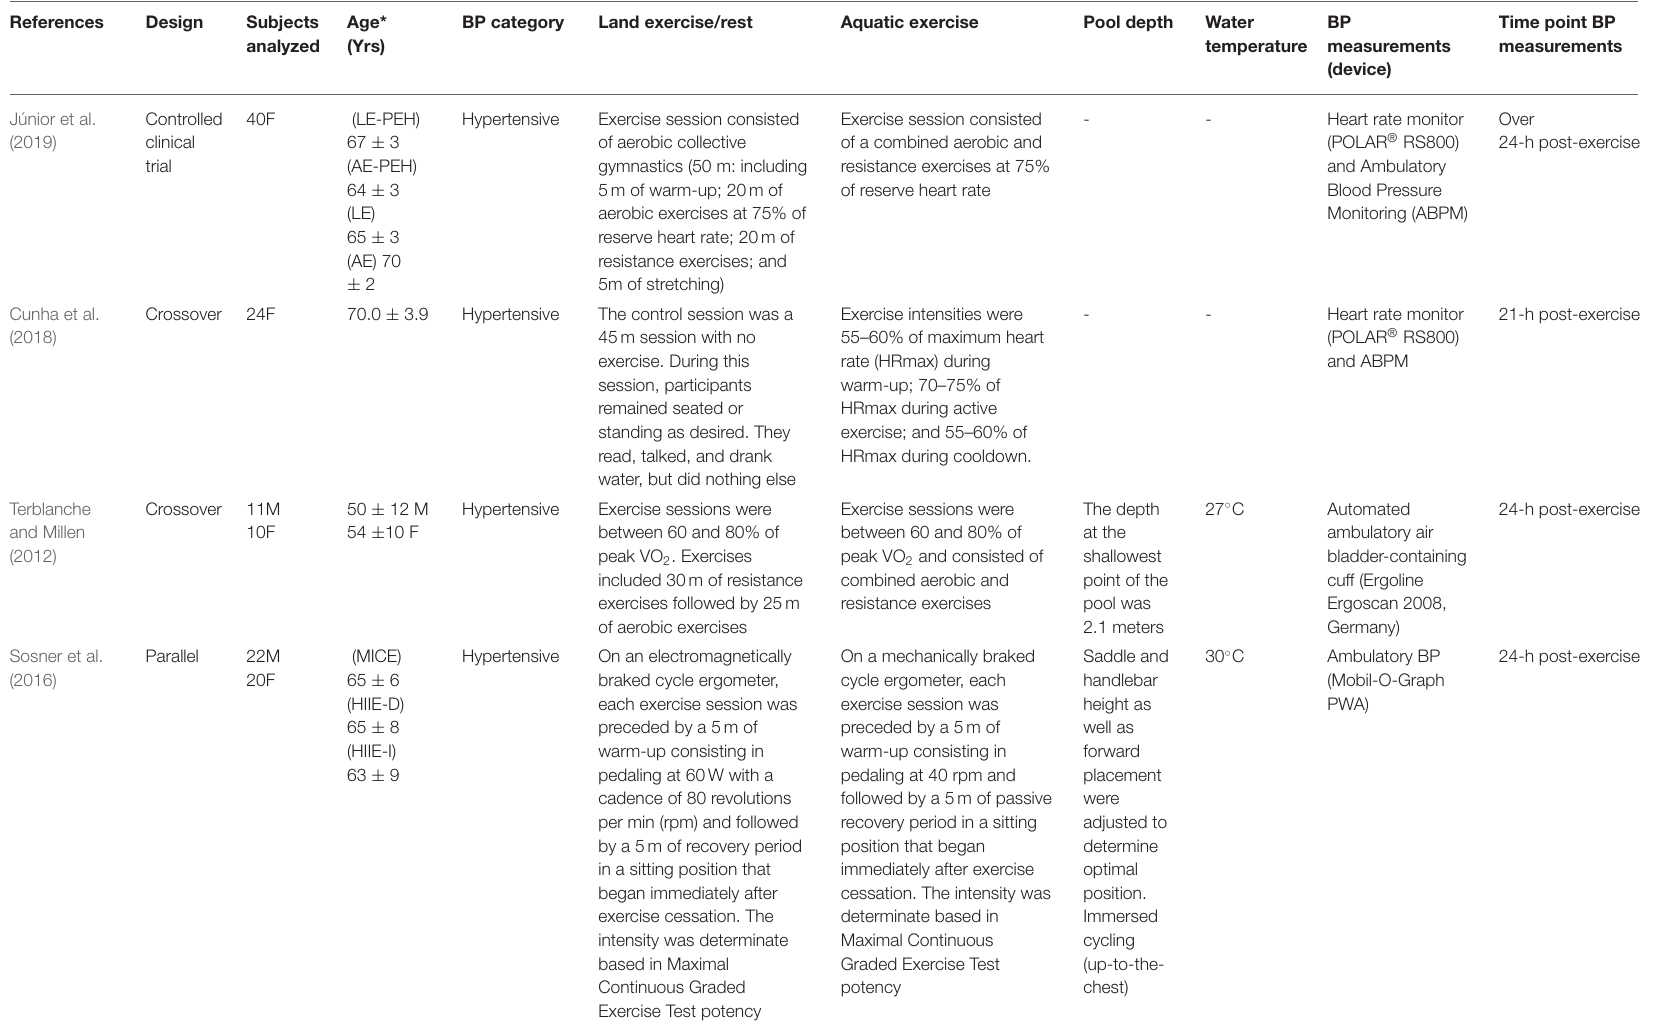
TABLE 4 | Overview of the general characteristics of the study and